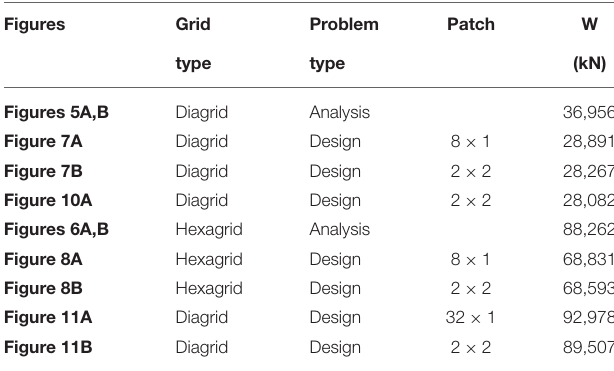
TABLE 2 | Tonnage of the analyzed/optimized structural